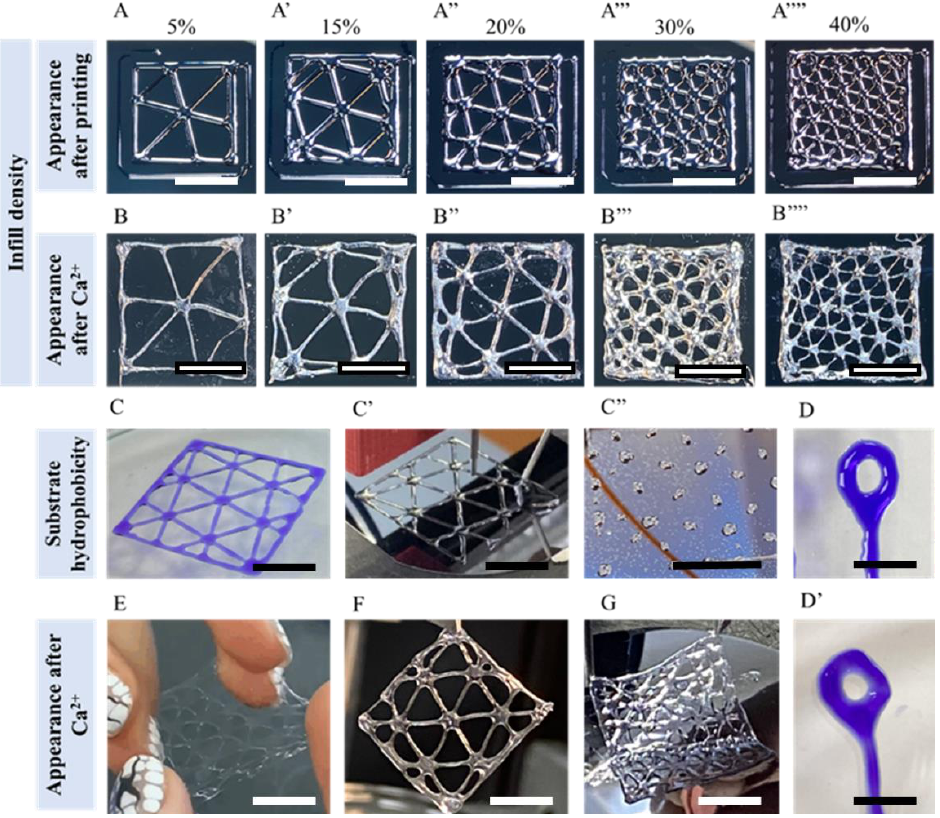
Figure 7. Tunable printing parameter, its consequences and possibilities of continuous printing. ( A ) 2 × 2 cm printed square with infill parameter ranging from 5 to 40% on a pure silicon plate, using a g24 sized needle, 4 wt% alginate based inks and the skirt line around a square to stabilize the ink flow. Scale bar is 1 cm. ( B ) the same objects from ( A ), but treated with calcium chloride saturated solution. Scale bar is 1 cm. ( C ) 4 × 4 cm square printed with 4 wt% alginate inks using a g20 sized needle on a different types of surface, from left to right: glass as hydrophilic surface, silicon plate as slightly hydrophobic surface, a fluorocarbon coated silicon plate as a highly hydrophobic surface. Scale bar is 2 cm. ( D ) printed complex shape of closed loop 4 mm in diameter, inks with a blue dye, ( D’ ) the same after hardening in calcium salt solution and capable of carrying a load. Scale bar is 0.5 cm for ( D ) and ( D’ ). ( E – G )squares of different infill, hardened and capable to carry a load. The scale bar is 2 cm.